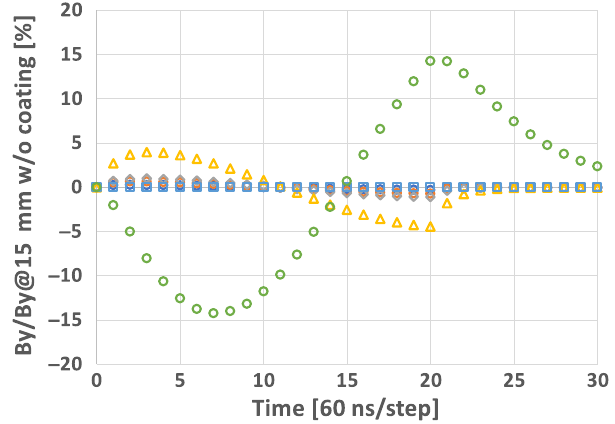
FIG. 11. Horizontal distribution with temporal evolution of the ratio between the vertical magnetic-field strength at each point in the case with a coating and the magnetic field at 15 mm in the case of no coating.